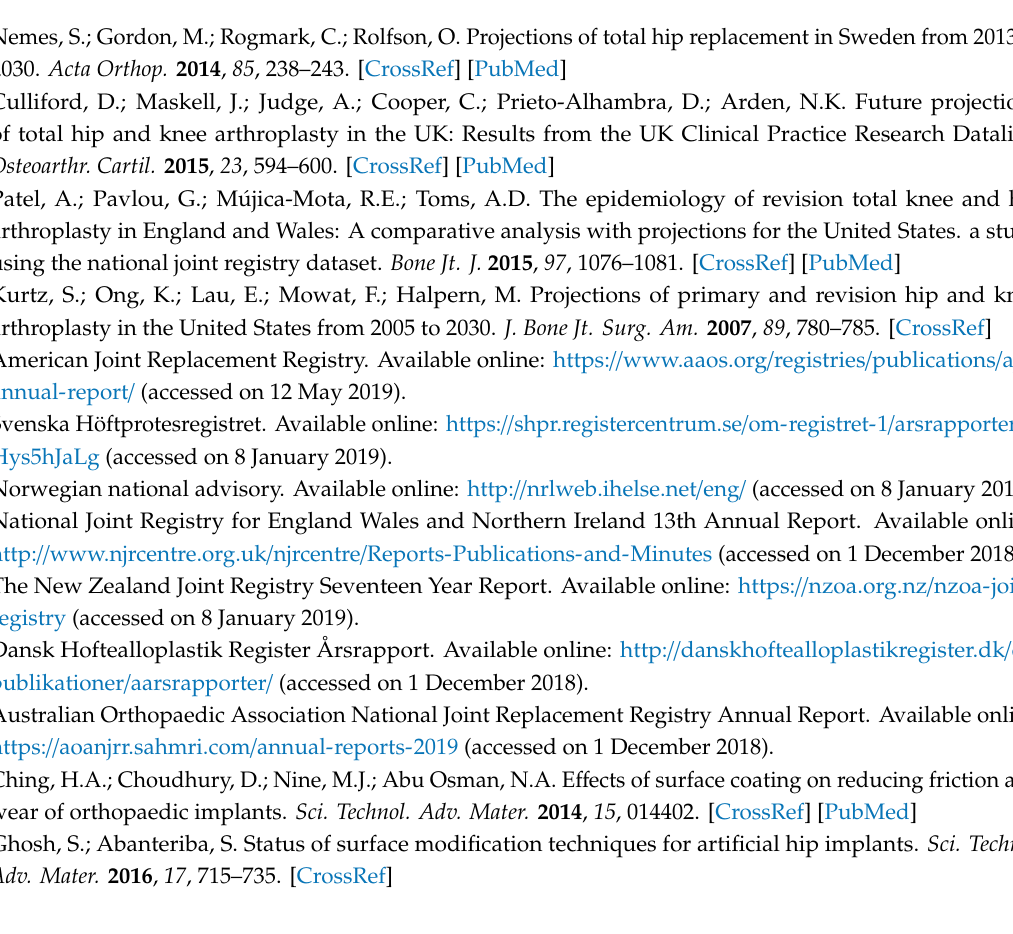
Figure S1: C as a function of Si, Figure S2: C as a function of y, Figure S3: Fe as a function of Si, Figure S4: Fe as a function of x, Figure S5: H as a function of Fe, Figure S6: H as a function of N, Figure S7: H as a function of O, Figure S8: H as a function of Si, Figure S9: H as a function of x, Figure S10: M as a function of Fe, Figure S11: M as a function of N, Figure S12: M as a function of O, Figure S13: M as a function of Si, Figure S14: M as a function of x, Figure S15: N as a function of C, Figure S16: N as a function of Fe, Figure S17: N as a function of Si, Figure S18: N as a function of x, Figure S19: O as a function of Fe, Figure S20: Si as a function of x, Figure S21: Thickness as a function of Si, Figure S22: Thickness as a function of x, Figure S23: Load displacement curves for all investigated points (1–5) as well as an uncoated